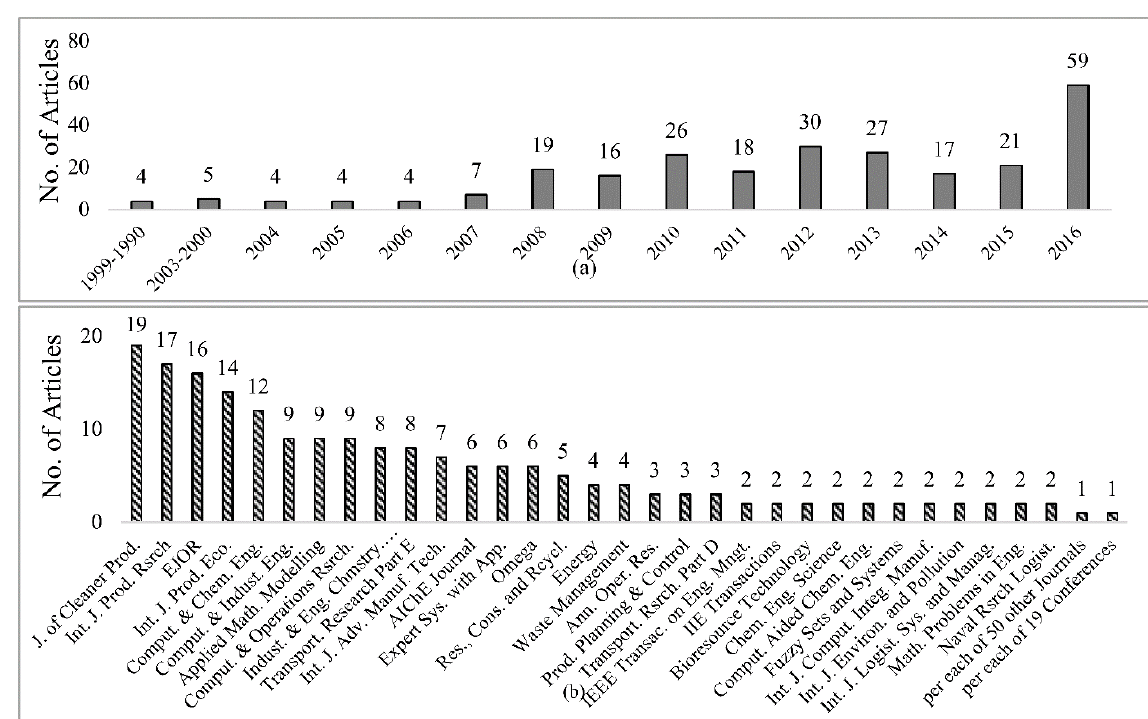
Figure 1. Distribution of collected articles a) over time; b) by